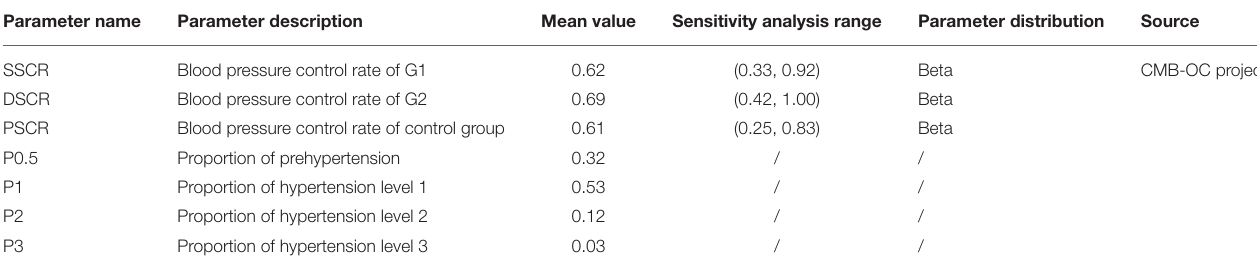
TABLE 1 | Blood pressure control rate, sensitivity analysis range, and parameter distribution.